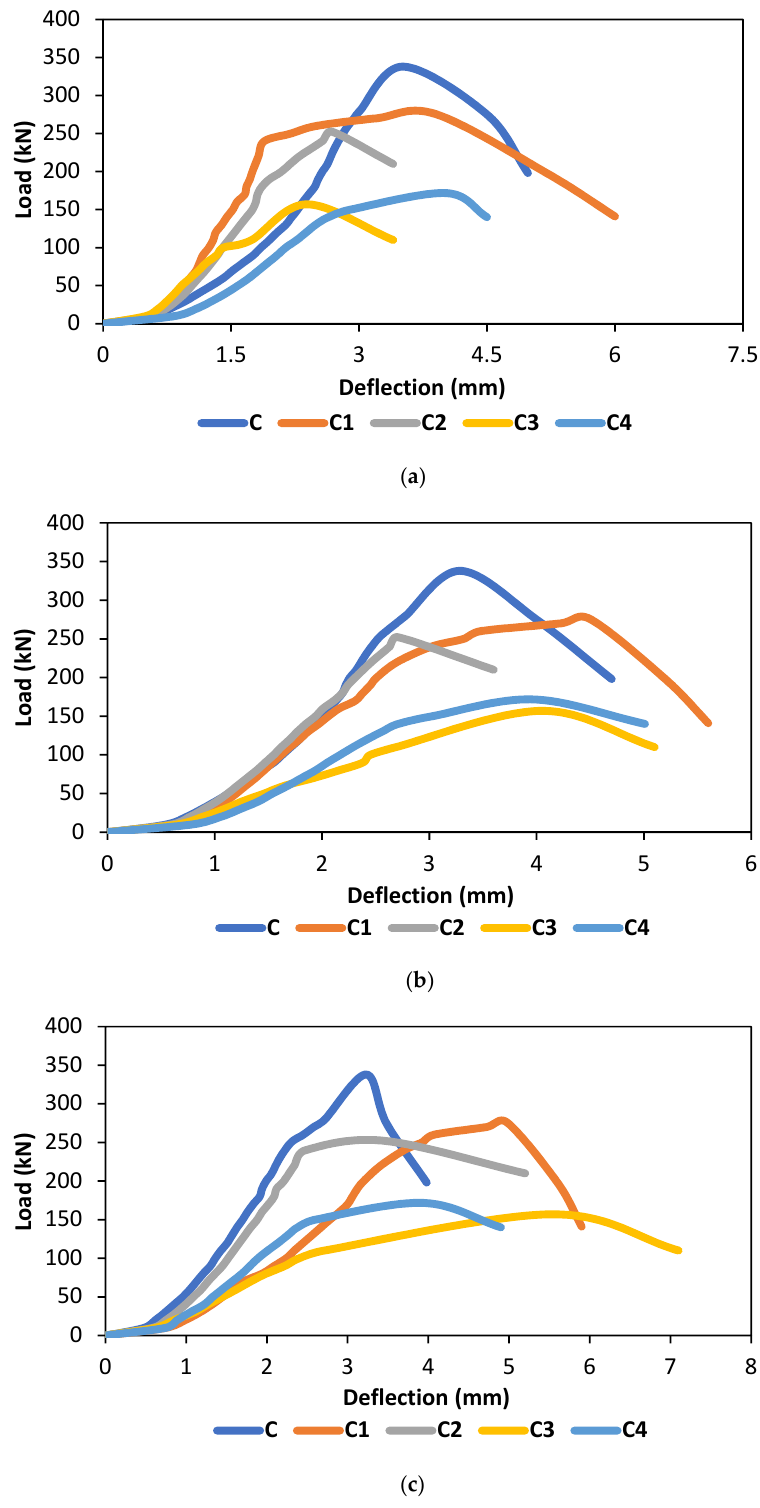
Figure 33. Load versus deformation profile of the specimens: ( a ) Top, ( b ) Middle, and ( c ) Bottom.